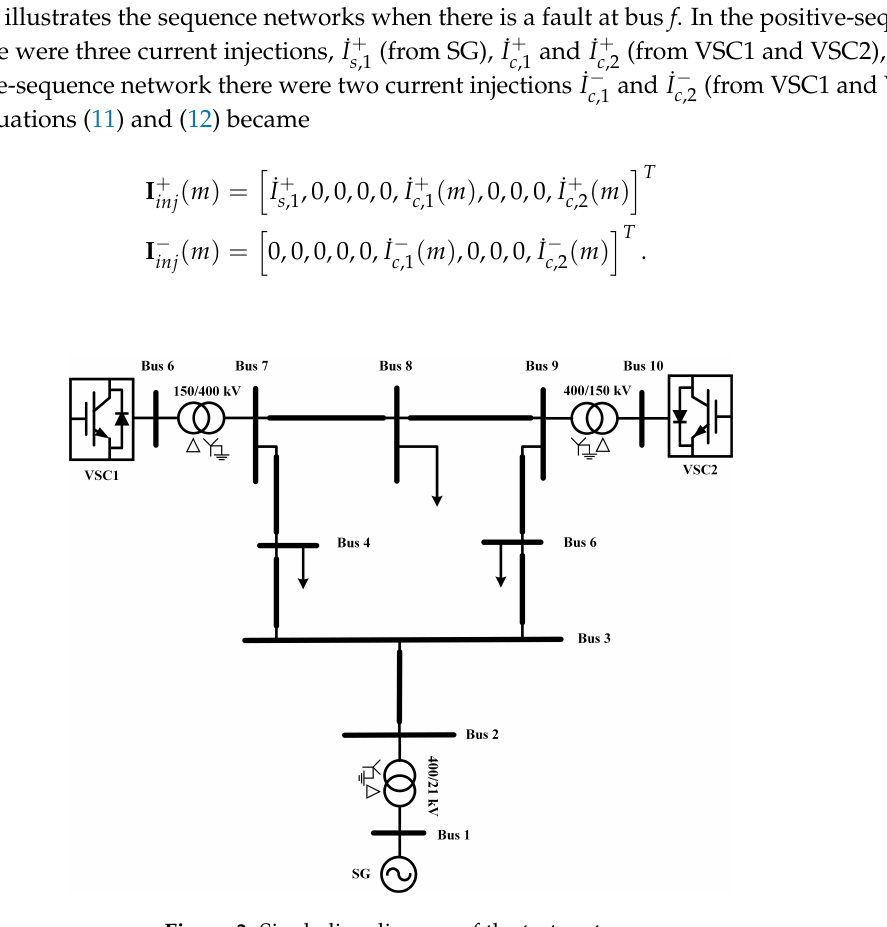
Figure 3. Single-line diagram of the test system.